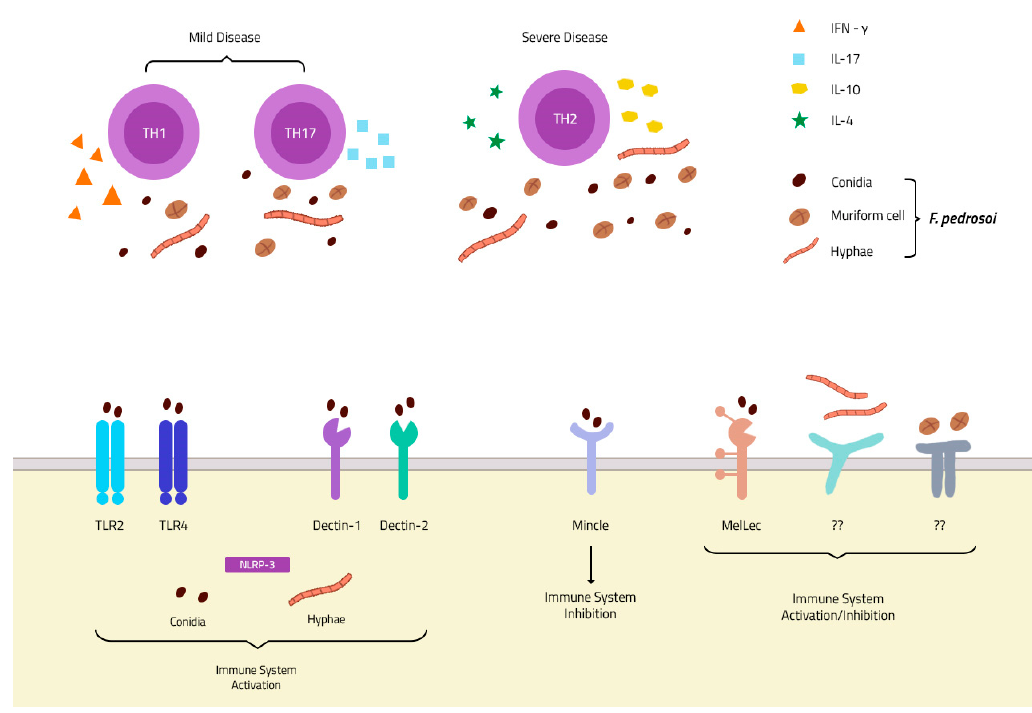
Figure 3. PRRs and immune response in chromoblastomycosis (CBM) infection: Membrane receptors of the TLR and CLR families described in F. pedrosoi conidia recognition. To date, only one receptor is described in hyphae recognition—the intracellular NLRP-3 inflammasome—and none is described in muriform cell recognition ( Bottom ). The Th1 and Th17 response is associated with mild disease, and an increase in IFN- γ and IL-17 secretion, while a Th2 response is related to severe disease with increases in IL-4 and IL-10 secretion and fungal spread ( Top ).